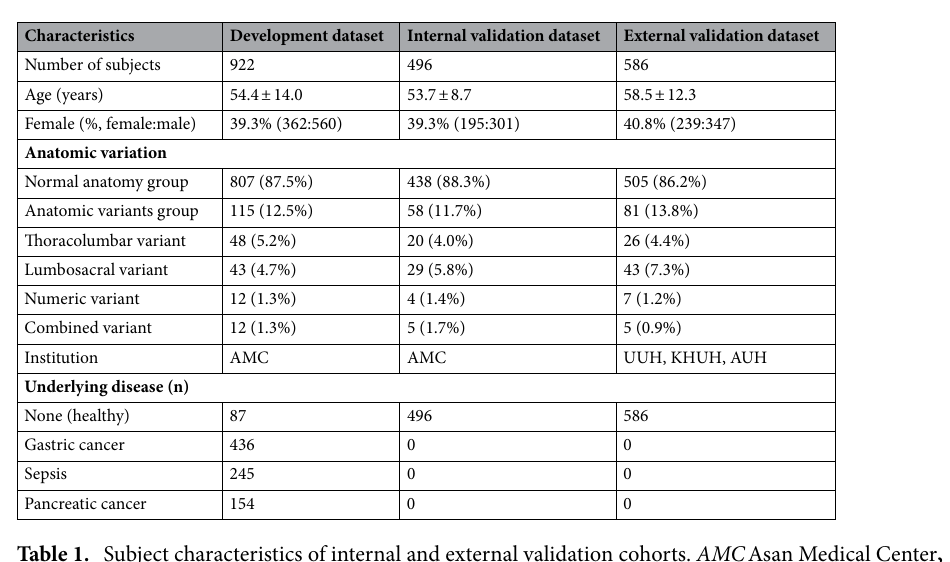
Table 1. Subject characteristics of internal and external validation cohorts. AMC Asan Medical Center , AUH Ajou University Hospital , KHUH Kyung Hee University Hospital , UUH Ulsan University Hospital.